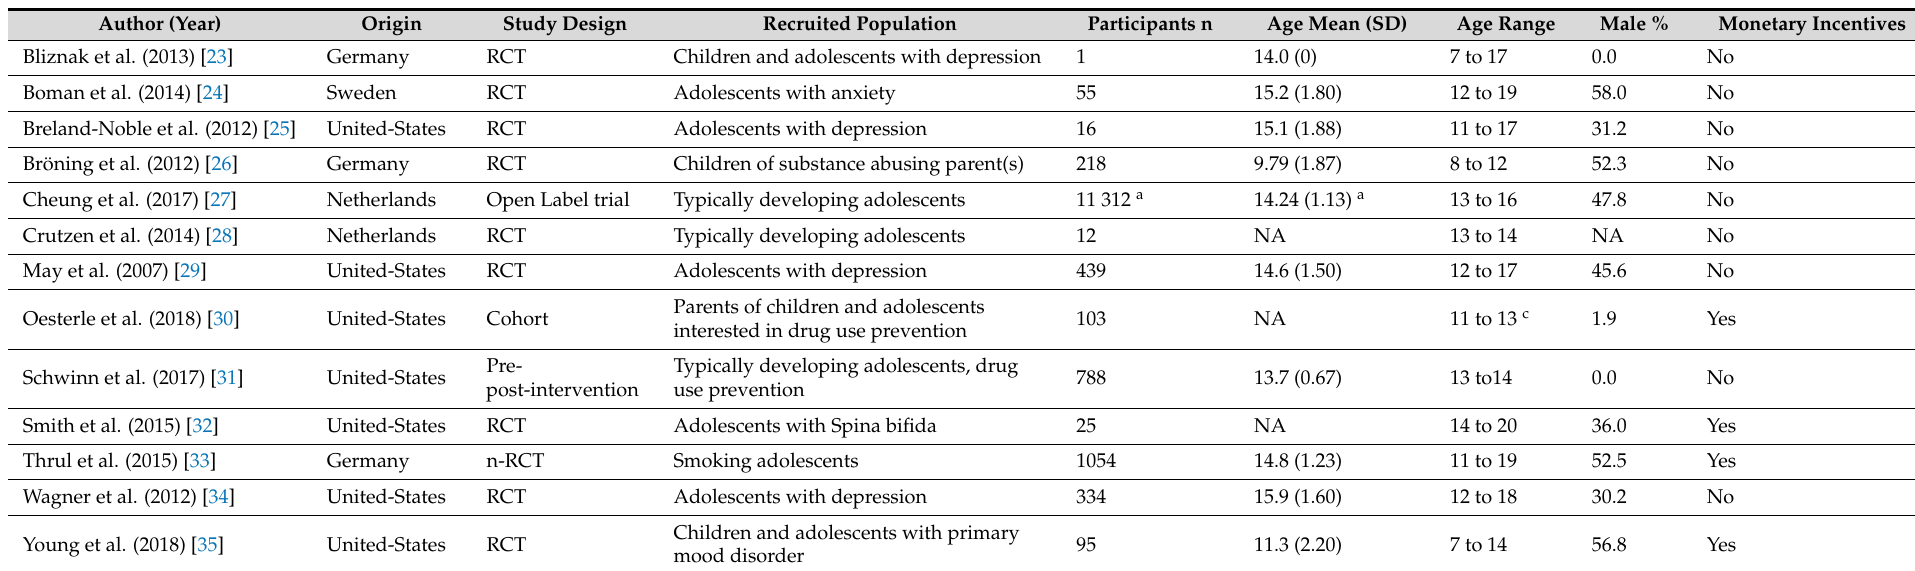
Table 2. Characteristics of included studies to improve recruitment for children and adolescents in mental